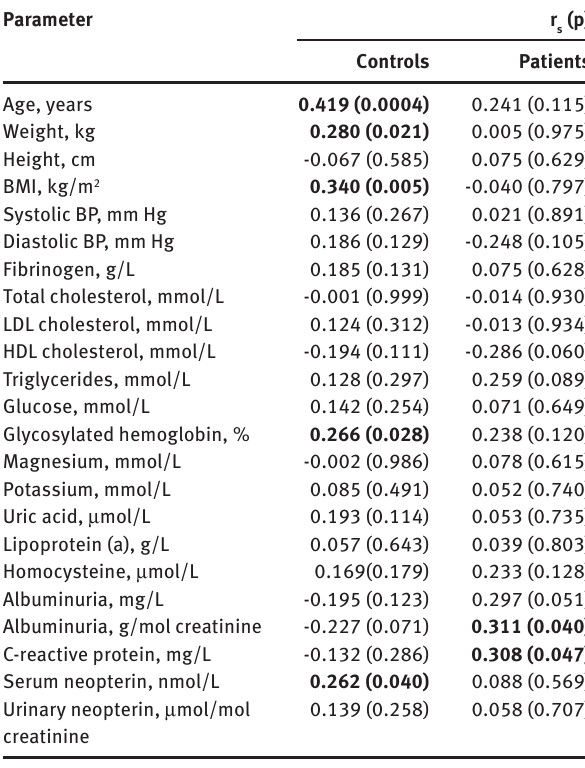
Table 4 Correlation of mean intima-media thickness with clinical and laboratory